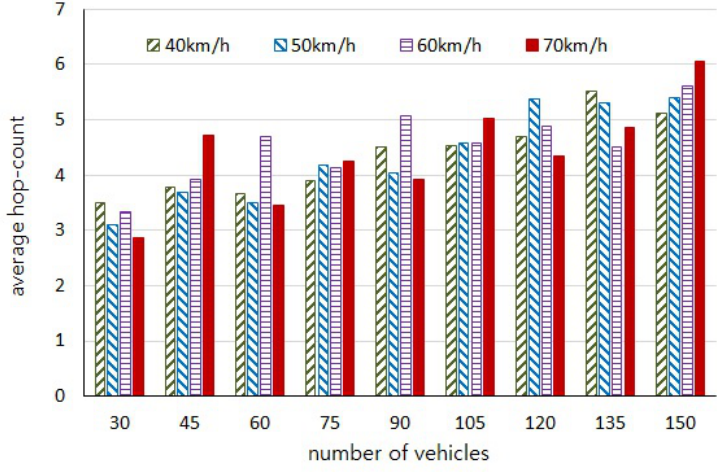
Figure 5. Average number of hops for forwarding messages to the destination